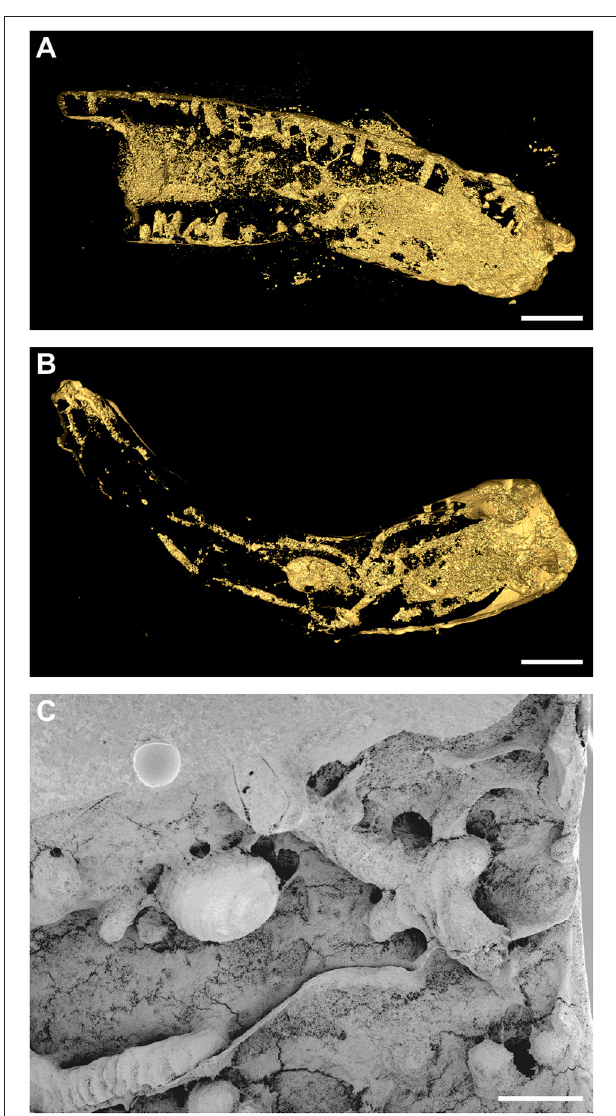
FIGURE 4 | (A) Pyrgopolon ( P. ) deforme with frequent, equally wide, and deep shafts of Trypanites isp.; MHNLM EMV 2016.3.22; three-dimensional micro-CT reconstruction. Le Mans, France (cf. Koˇcová Veselská et al., 2021, Figure 6B). (B) single-chamber specimen of Entobia isp. with long branching galleries occupying the whole specimen of Pyrgopolon ( P. ) deforme, MHNLM EMV 2016.3.14, three-dimensional micro-CT reconstruction. Le Mans, France (cf. Koˇcová Veselská et al., 2021, Figure 7C). (C) Pyrgopolon ( P. ) deforme with network of Entobia exploratory tunnels and one larger, smooth chamber, SEM image of casted MHNLM EMV 2016.3.18, Le Mans, France (cf. Koˇcová Veselská et al., 2021, Figure 8A). Scale bars = 1mm (A) , 2mm (B) , and 400 µ m (C)